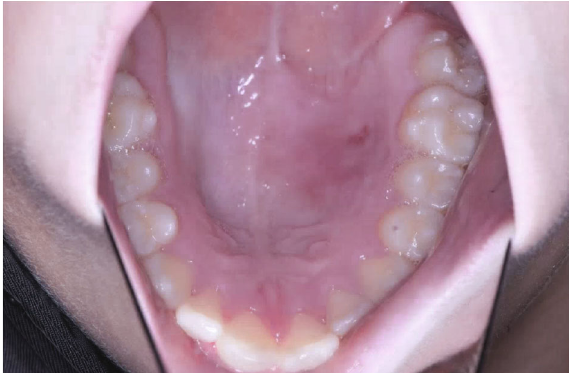
Figure 7: Photograph of the postoperative healing 4 months after